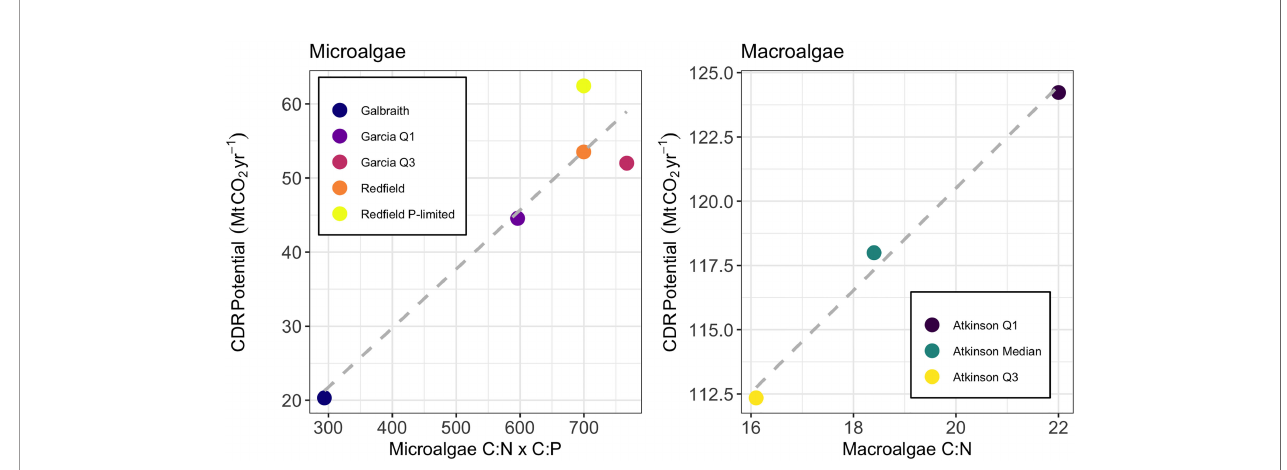
FIGURE 6 | Controls on carbon dioxide removal potential of microalgae (left panel) and macroalgae (right panel). Grey dashed lines show linear models for each type of algae. Carbon-to-nitrogen and carbon-to-phosphorus values for the Galbraith model were chosen by calculating values for all locations and depths displayed in Figure S2 and selecting the median values of carbon-to-nitrogen and carbon-to-phosphorus from the